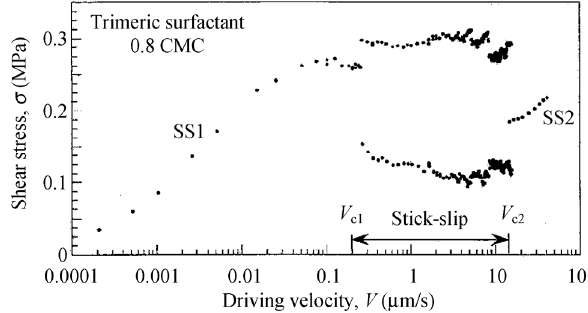
Fig. 9 Dependence of shear stress on driving velocity while shear- ing two adsorbed monolayers of trimeric ammonium tribromide- based surfactant from aqueous solutions at T =20 °C. Reproduced with permission from [88]. Copyright AIP,